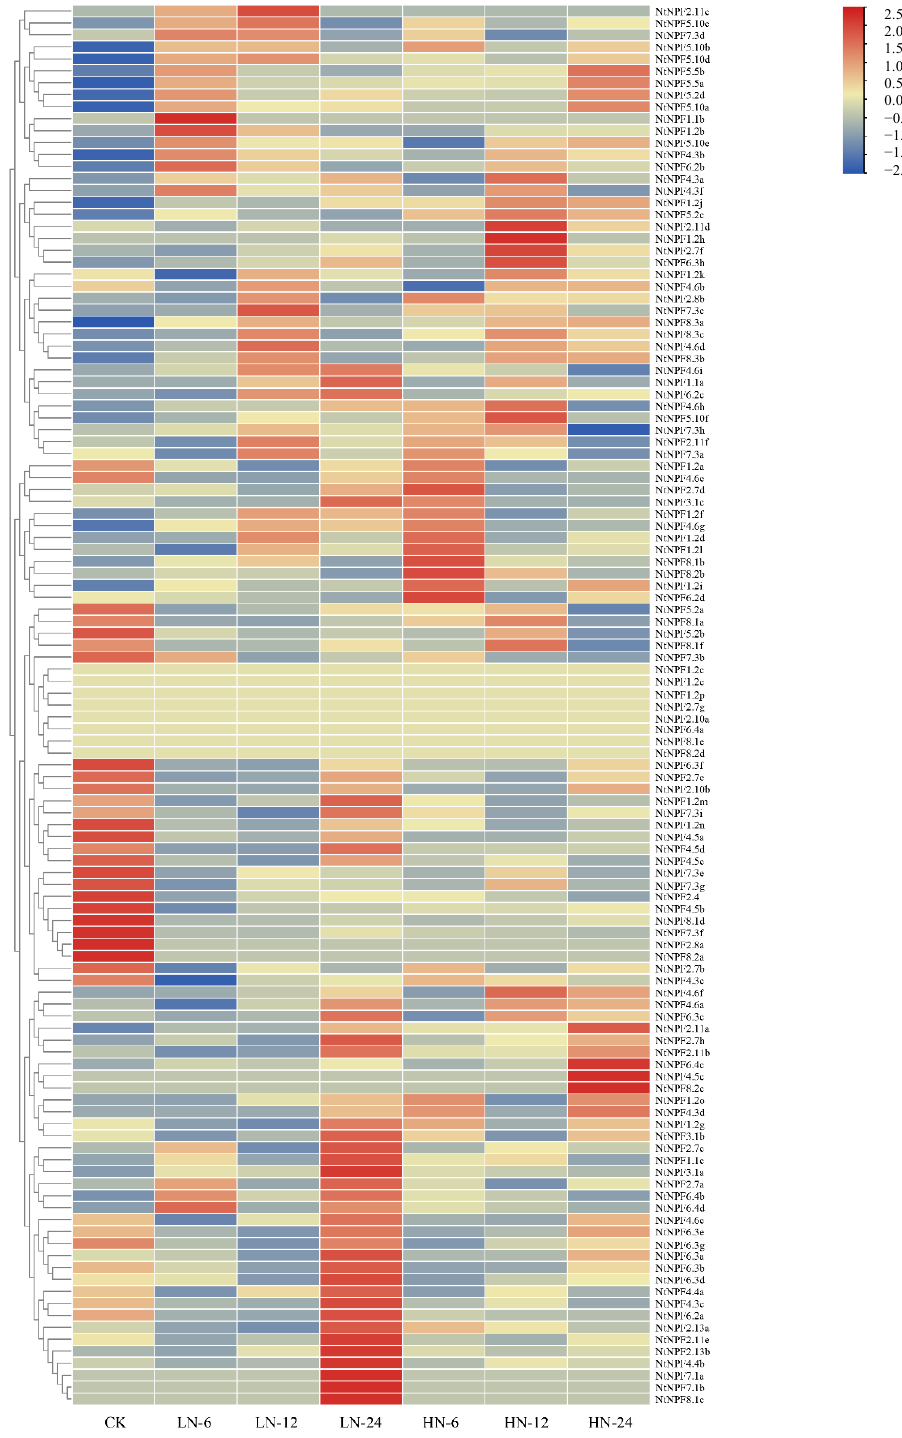
Figure 6. The hierarchical cluster heat map showing NtNPF gene expression levels in tobacco root. The seedlings of tobacco were cultivated in a hydroponic system. Plants with approximately 10 cm of leaves in length and with similar sizes were used for nitrate treatments, including high (HN) and low (LN) nitrate concentrations. The root samples were harvested at different time points, including 0 (CK), 6, 12, and 24 h. Three biological replicates for each subgroup were applied.